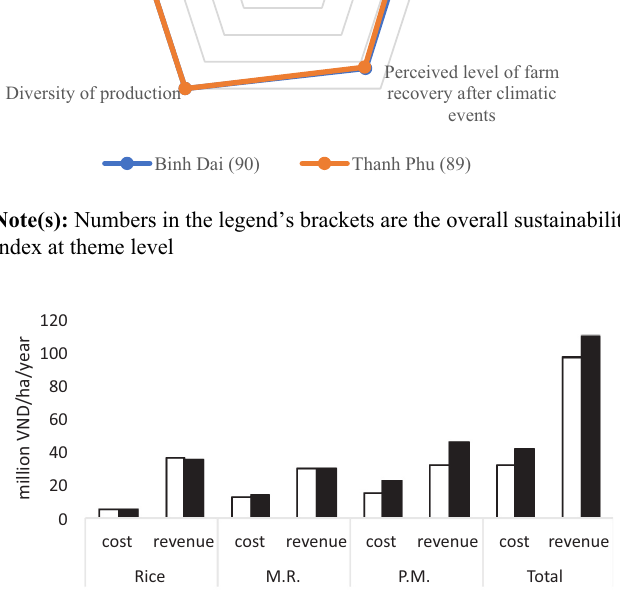
Figure 9. Average benefit cost structure of rice- shrimp system